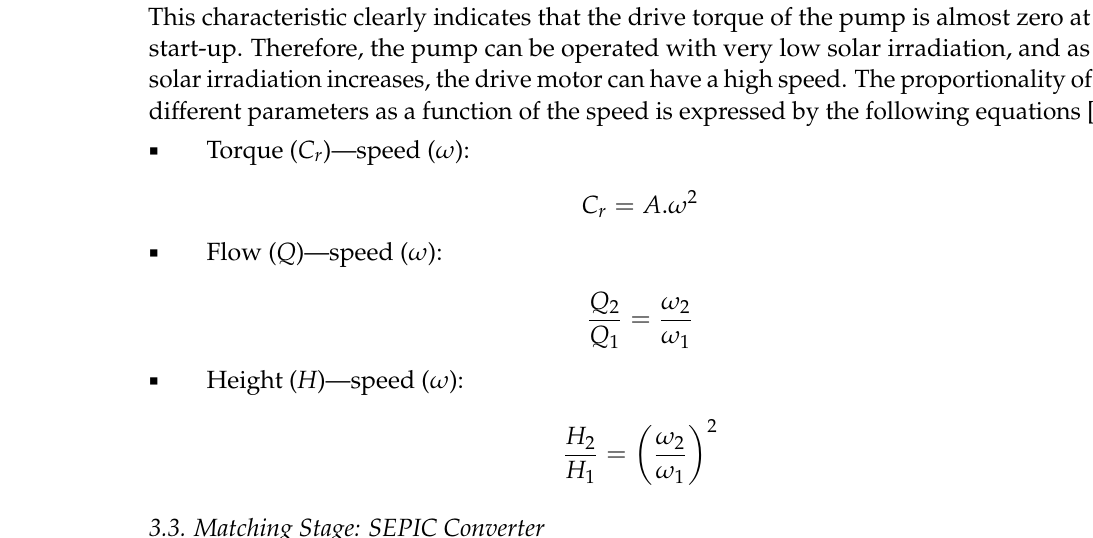
Figure 4. Electrical diagram of a SEPIC converter [28].